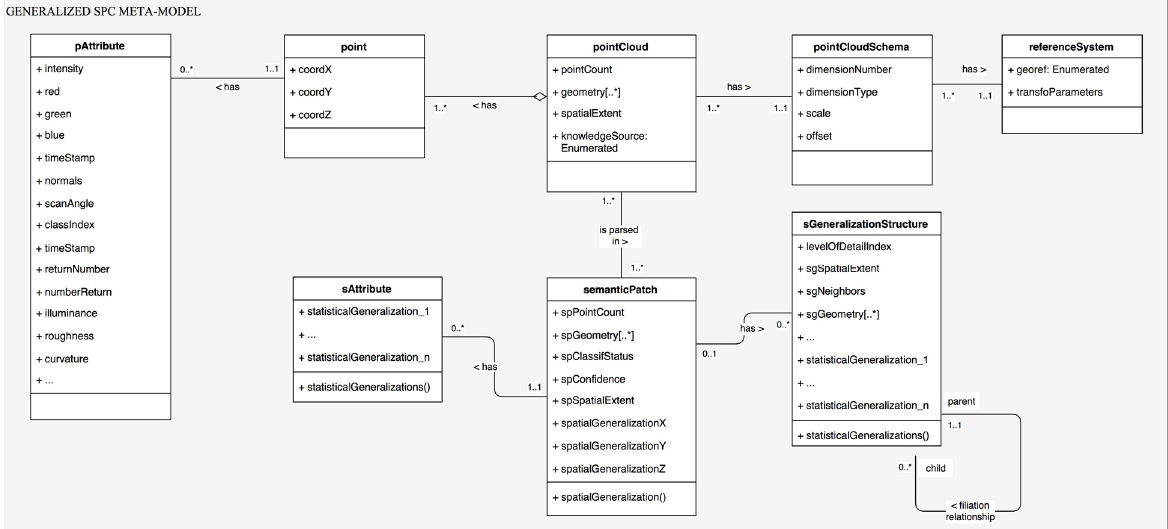
Figure 2 Level-0 Generalized SPC meta-model (UML). A point cloud constituted of points is block-wise organized through semantic patches. These can be pure spatial conglomerate or retain a coherent semantic relationship between constituting